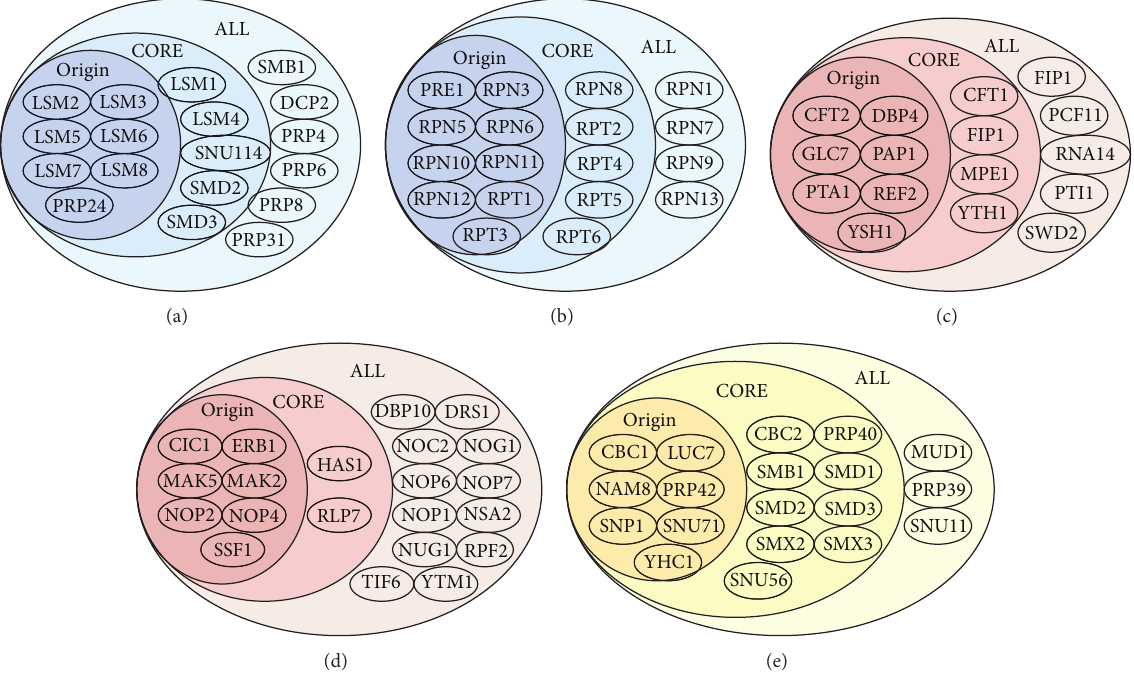
Figure 5: Cliques extended by the predicted PPIs from CORE and ALL have high functional significance and physical meaning.